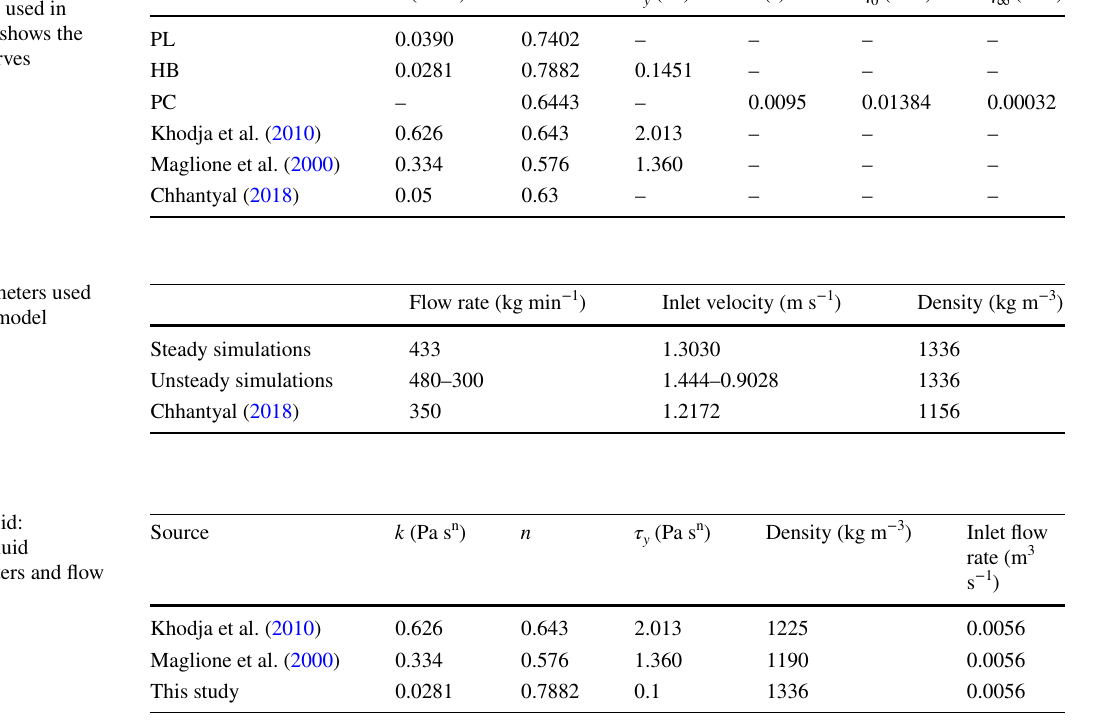
of the drilling muds used in this study. Figure 4 shows the related rheology curves